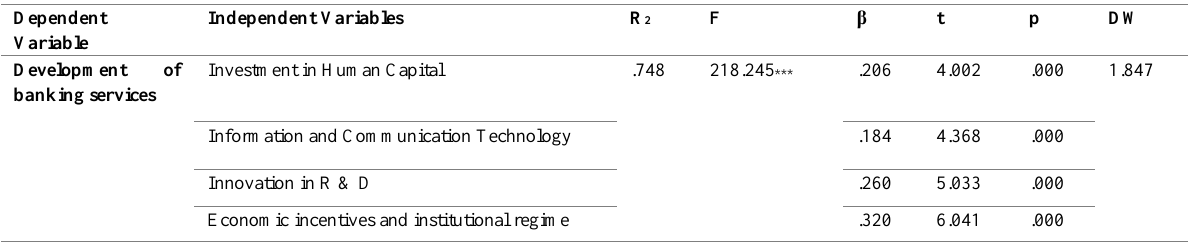
Table 8: Regression Analysis of the Main Study Variables